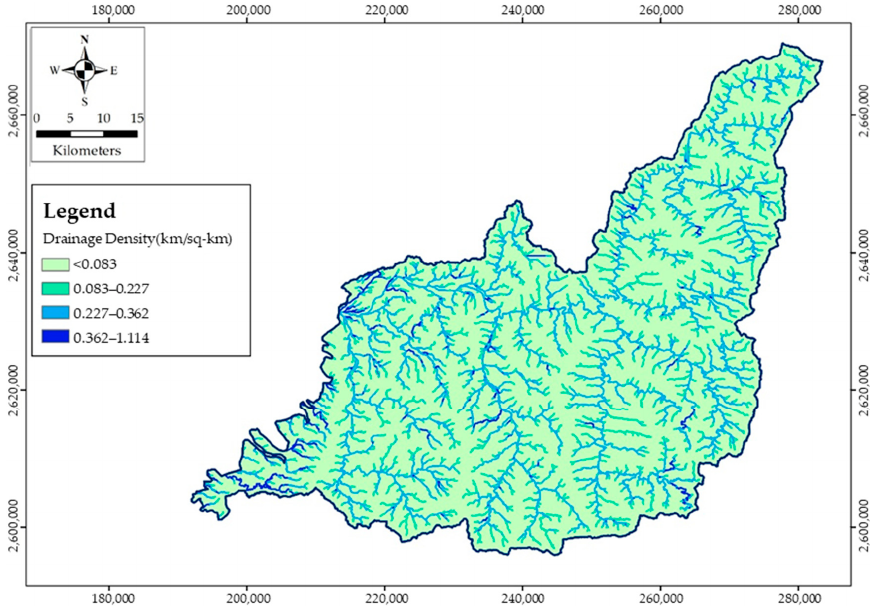
Figure 4. Drainage density distribution of the study